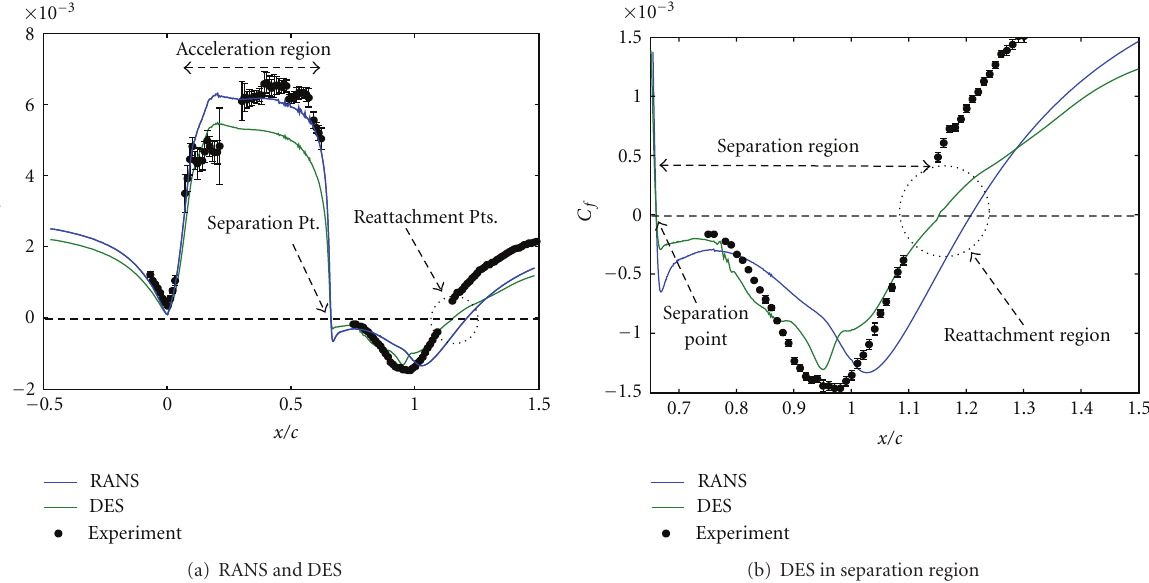
Figure 8: Predicted skin friction of time-averaged RANS and DES.